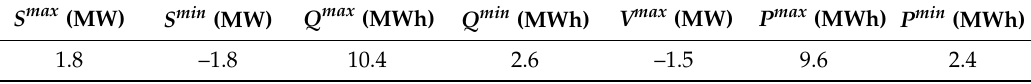
Table 2. Specifications of aggregated ESS and aggregated CL.